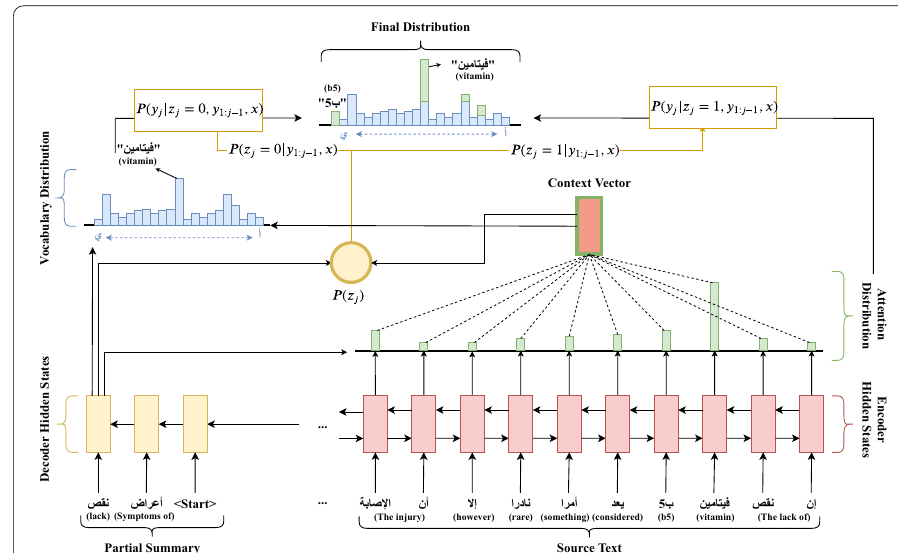
Fig. 1 Pointer‑generator model. Derived from See et al.